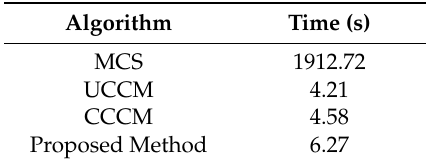
Table 5. Computation time table for the modified IEEE 9-bus test system.